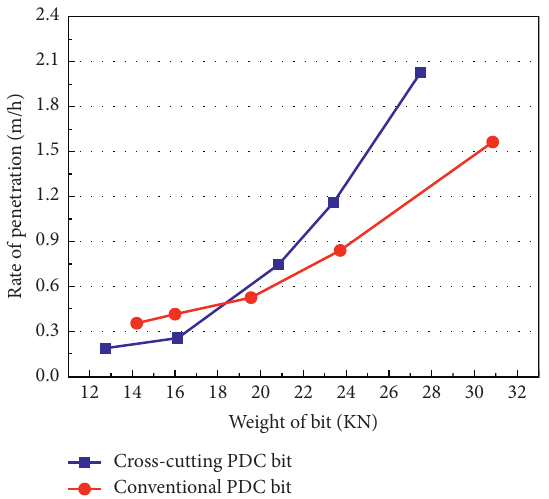
Figure 26: Relationship between WOB and ROP during drilling limestone.